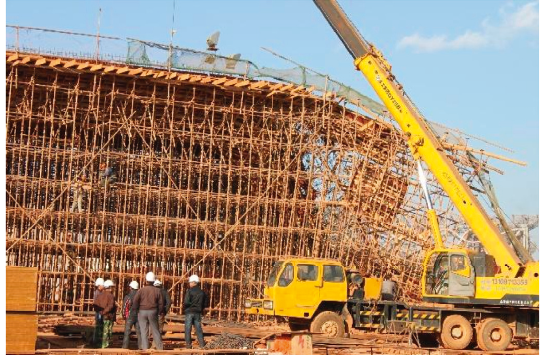
Figure 2: Excessive consider of economy leads to the collapse of the support during the concreting